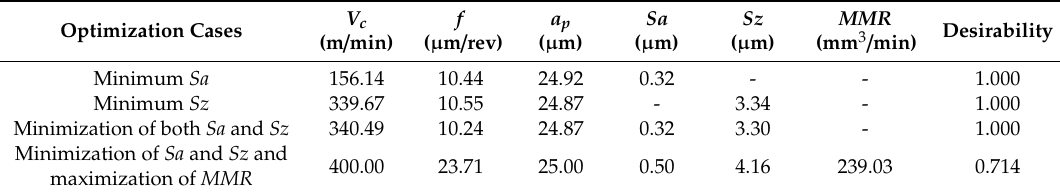
Table 13. List of solutions for the combinations of target